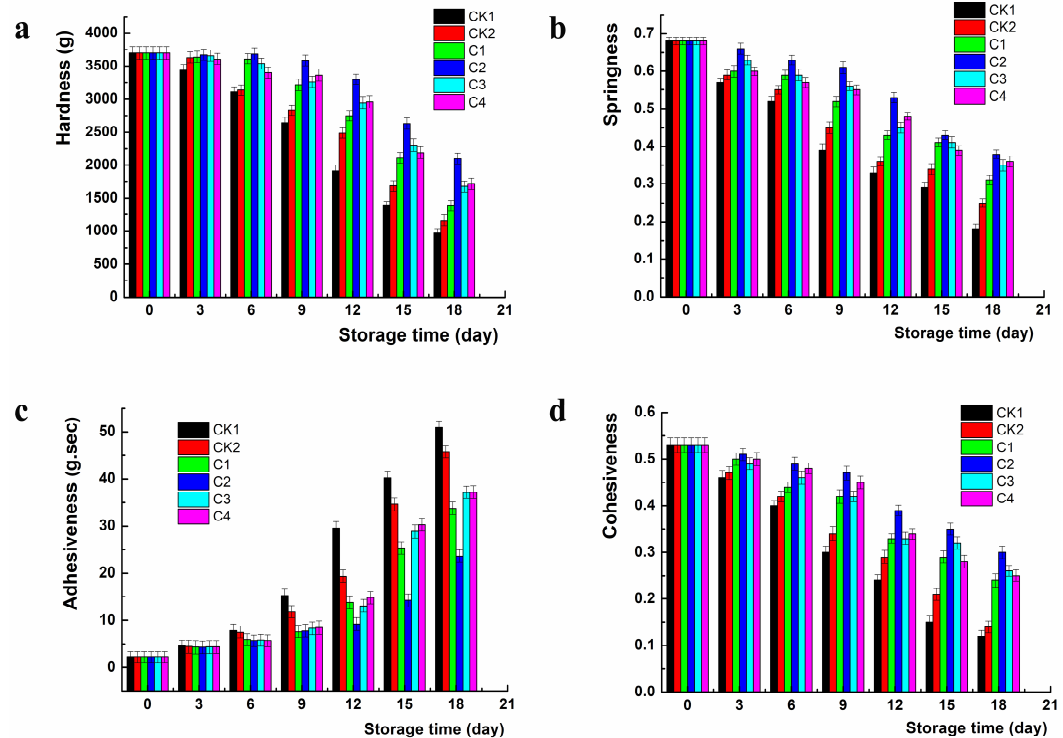
Figure 3. Changes in hardness ( a ), springiness ( b ), adhesiveness ( c ), and cohesiveness ( d ) of half-smooth tongue sole fillets during refrigerated storage (CK1: Chitosan coating without rosmarinic acid or ε-PL; CK2: Chitosan coating with 30 mg/kg rosmarinic acid; C1/C2/C3/C4: Chitosan coating with 30 mg/kg rosmarinic acid and 0.05%/0.10%/0.15%/0.20% ε-PL).